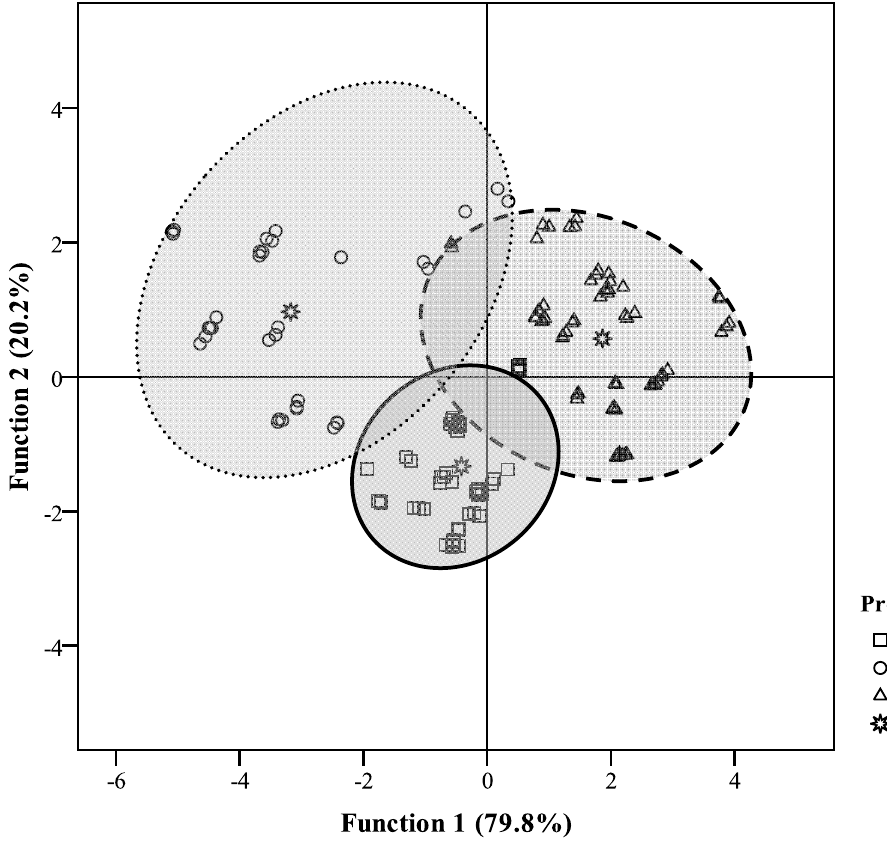
Figure 1. All-groups scatter plot for linear discriminant analysis of different “tea” formulations according with antioxidant activity and bioactive compounds